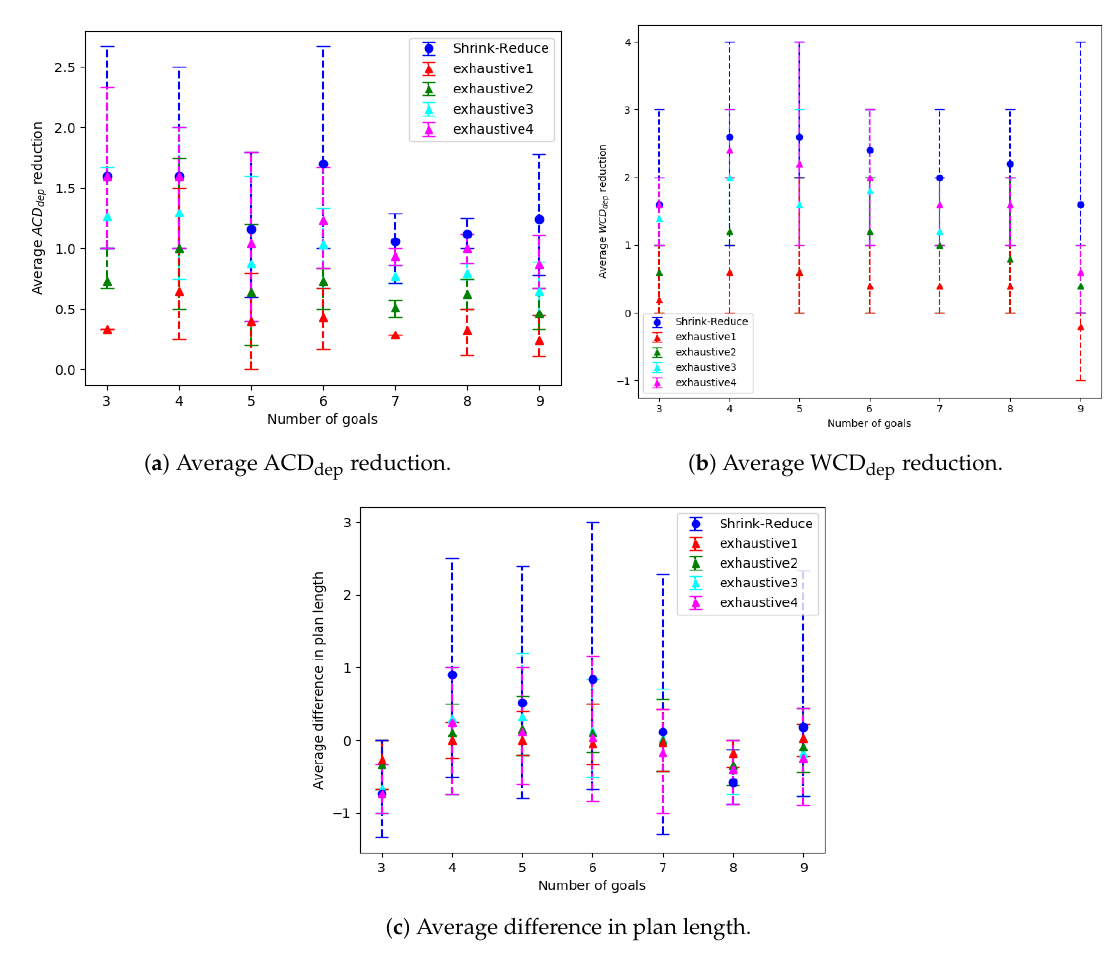
Figure A3. Results for an increasing number of goals.